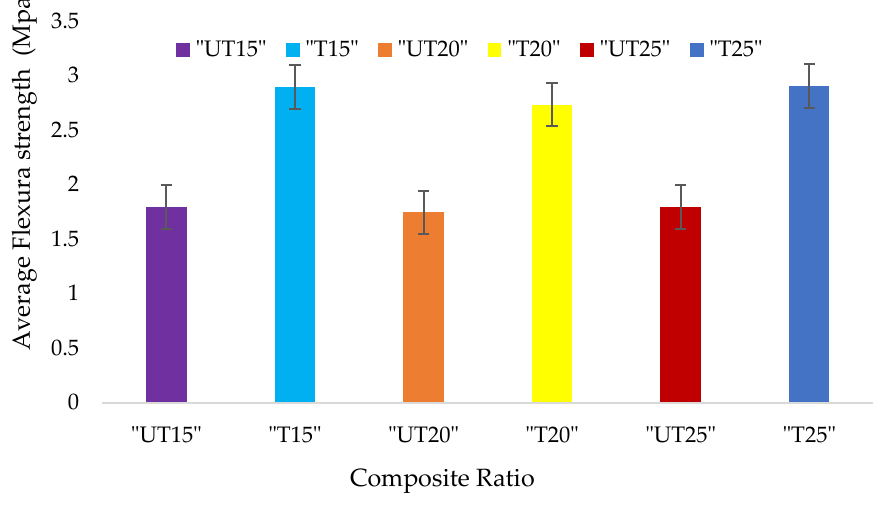
Figure 4. Flexural strength results.